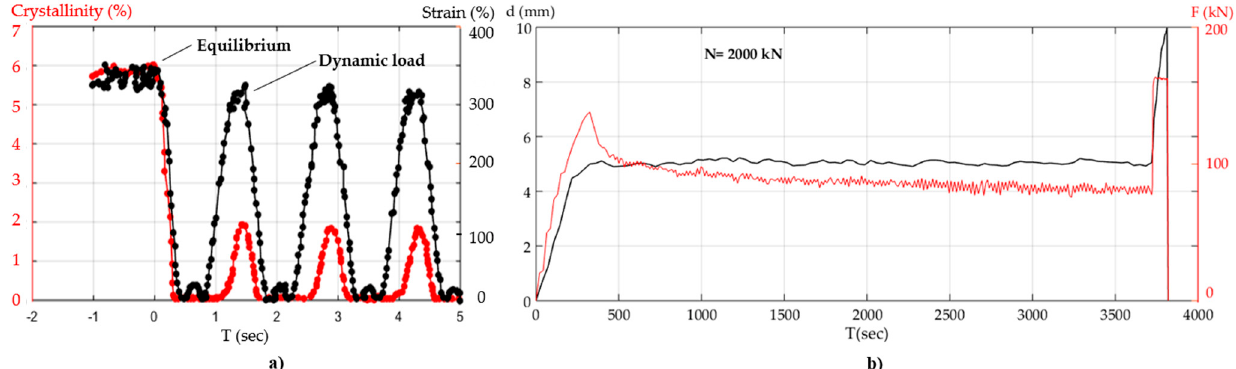
Figure 23. Crystallinity and Relaxation for Natural Rubbers (NRs): ( a ) crystallinity as a function of time under dynamic loading at a frequency of 1 Hz (data from [46]); ( b ) time histories of displacement (black line) and applied force (red line), for a displacement-controlled test on a LRB isolator with diameter of 45 cm (data from [49]).